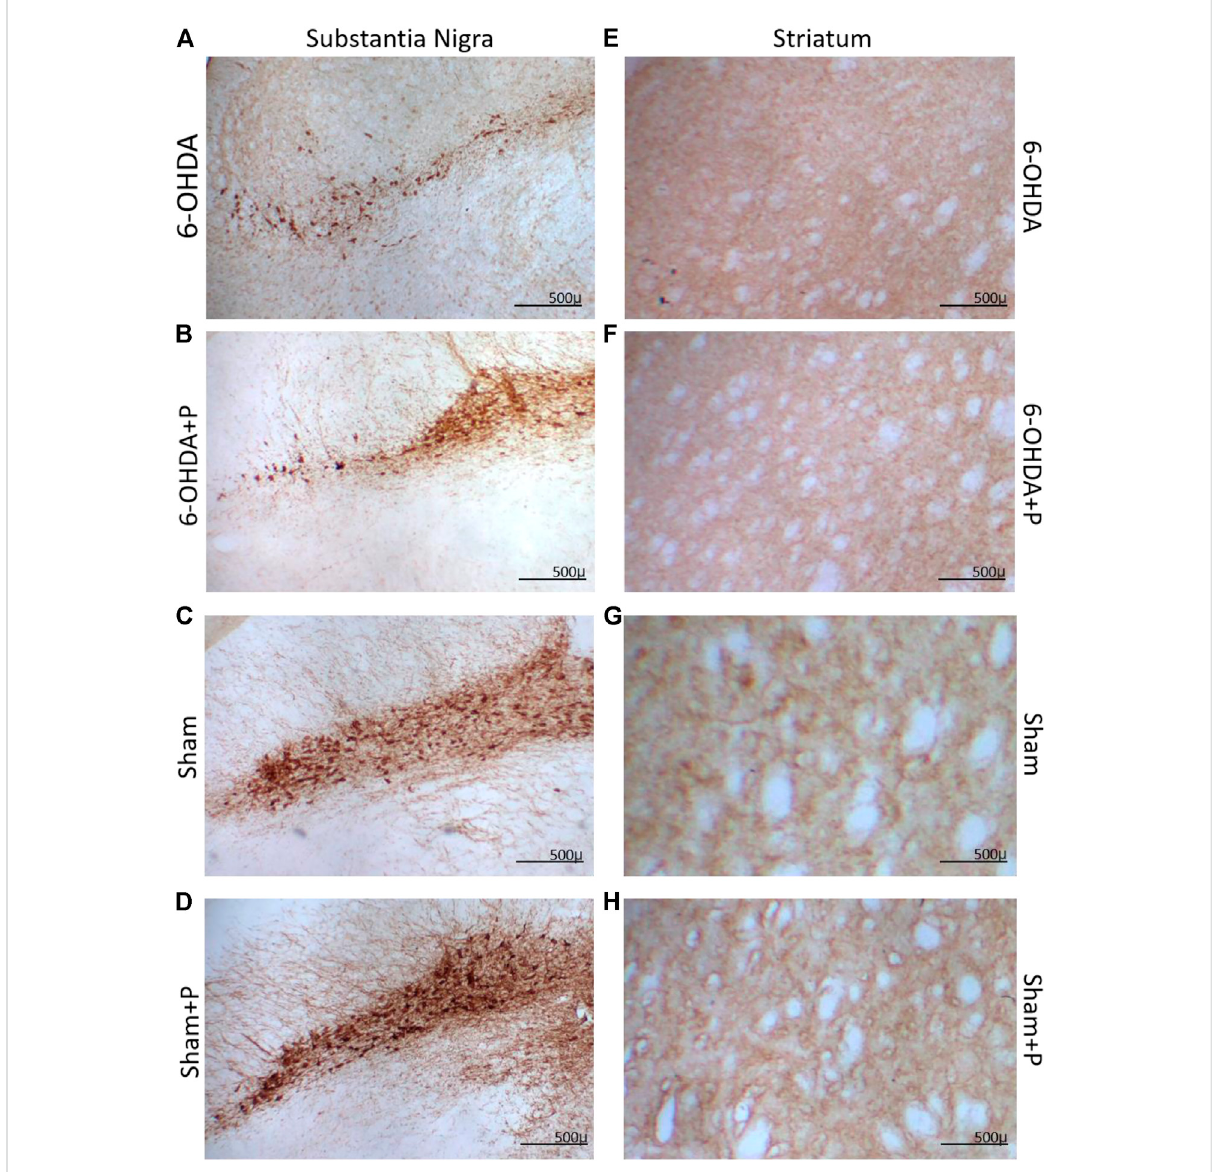
FIGURE 3 Illustrativeimagesoftyrosinehydroxylase(TH)immunoreactivesections.Dopaminergicneuronsinthesubstantianigraparscompactain (A) 6- OHDA; (B) 6-OHDA + P; (C) Sham; (D) Sham + P. Striatal fi bers in (E) 6-OHDA; (F) 6-OHDA + P; (G) Sham; (H) Sham + P. Note stronger TH-positive staining in the propolis-treated parkinsonian rats (B,F) in comparison to sham (A,E)